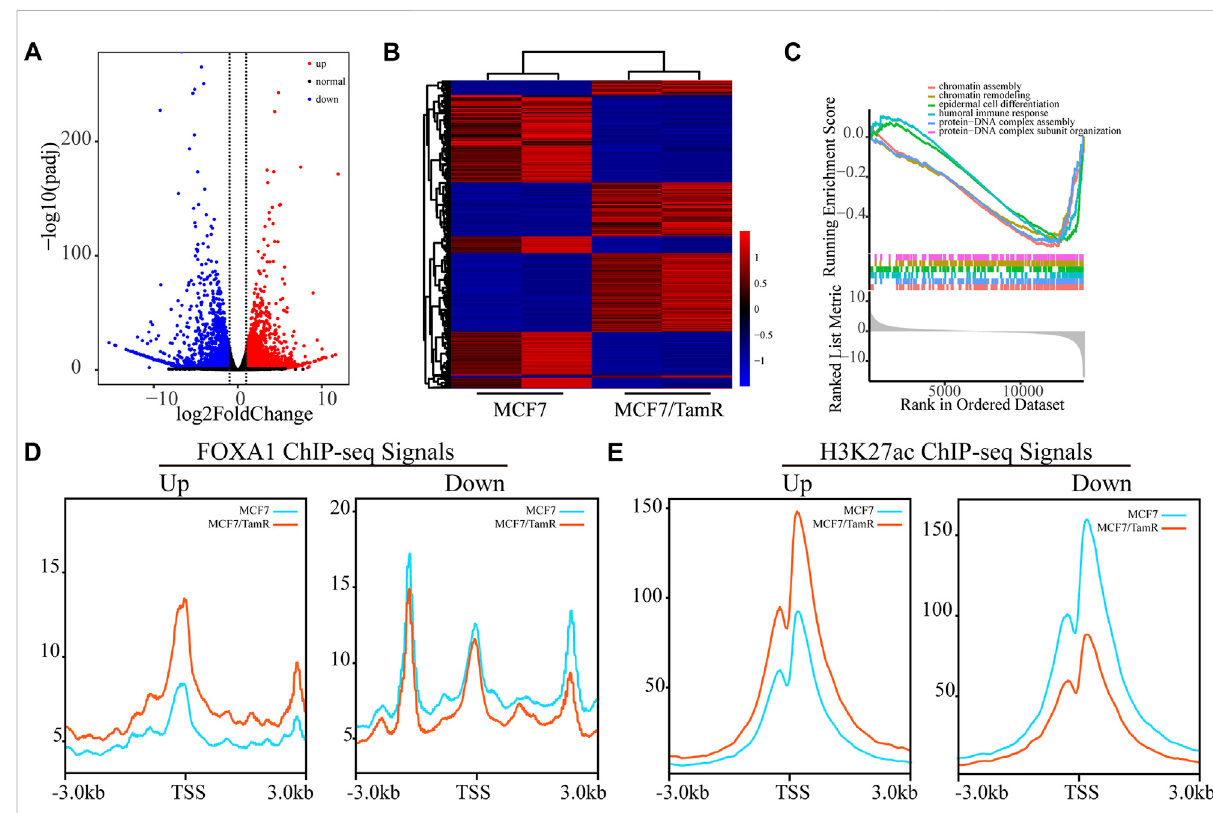
FOXA1 cistromes synchronize the transcriptional activity in tamoxifen resistance. (A) Volcano plot of the RNA expression pro fi le in MCF7 and MCF7/TamR cells, red dot represents upregulated RNA, black dot represents normal RNAand bluedot represents downregulated RNA. (B) Heatmap of the misregulated RNA expression pro fi le in MCF7 and MCF7/TamR cells. (C) GSEA analysis of the misregulated RNAs. The FOXA1 (D) and H3K27ac (E) chromatin binding densities plot of the upregulated and downregulated RNAs in MCF7 and MCF7/TamR cells, red line represents MCF7/ TamR cells and the blue line represents MCF7